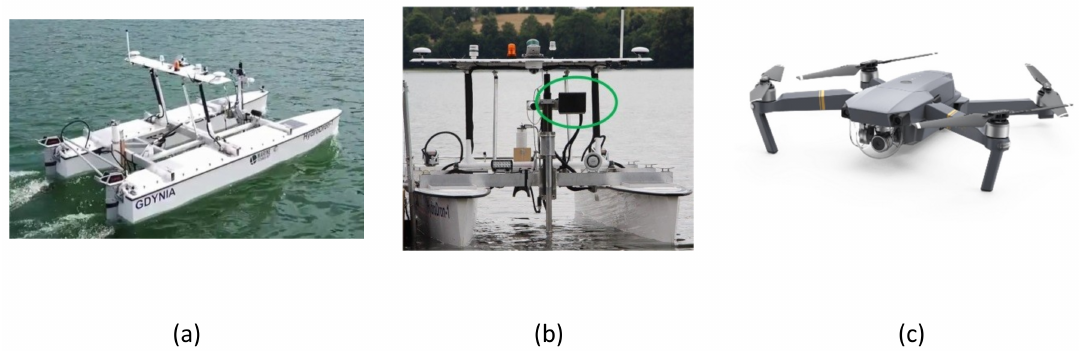
Figure 1. Research equipment: ( a ) ASV (Marine Technology HydroDron-1); ( b ) radar (Smartmicro